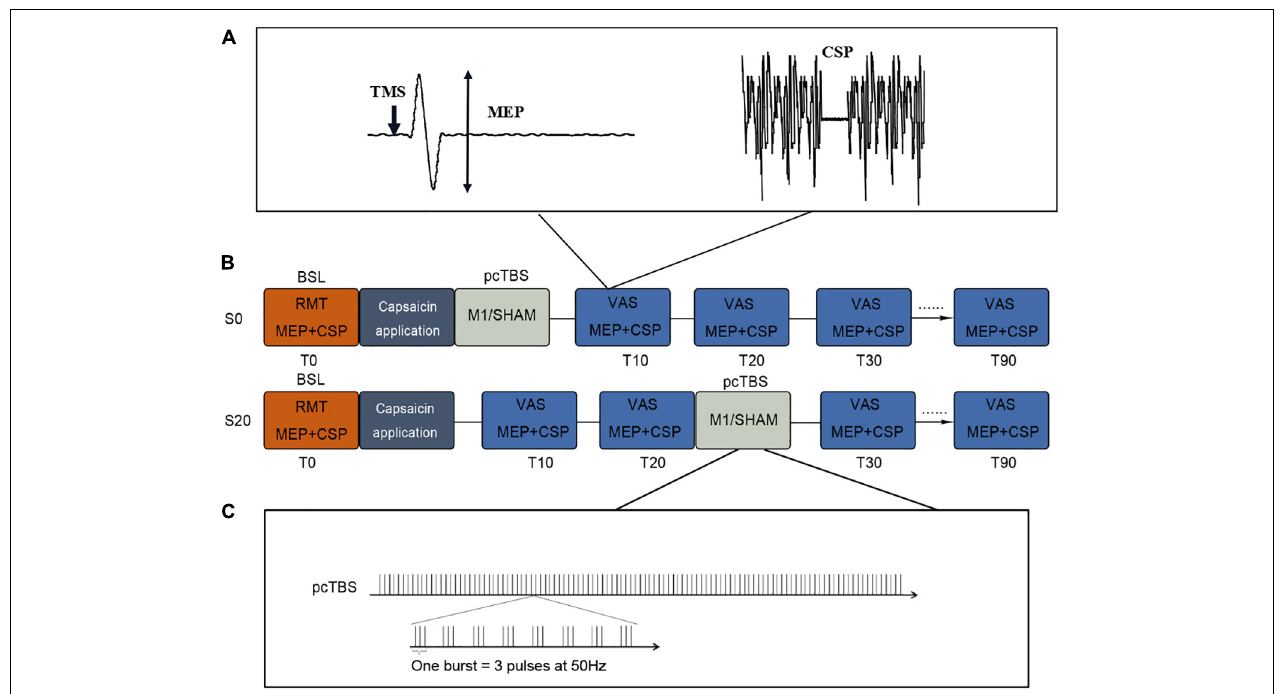
FIGURE 1 | Study design of this study. (A) MEP and CSP protocols. (B) Study protocol. pcTBS was delivered immediately (S0) or 20 min (S20) after capsaicin application. Sham stimulation was randomized to these two conditions at a 50% chance. Pain intensity (VAS) and cortical excitability (MEP and CSP) were evaluated every 10 min up to 90 min. (C) pcTBS protocol. pcTBS consists of a burst of 3 pulses given at 50 Hz repeated every 5 Hz, totaling 1,200 consecutive pulses. RMT, resting motor threshold; MEP, motor-evoked potential; CSP, cortical silent period; VAS, visual analog scale.